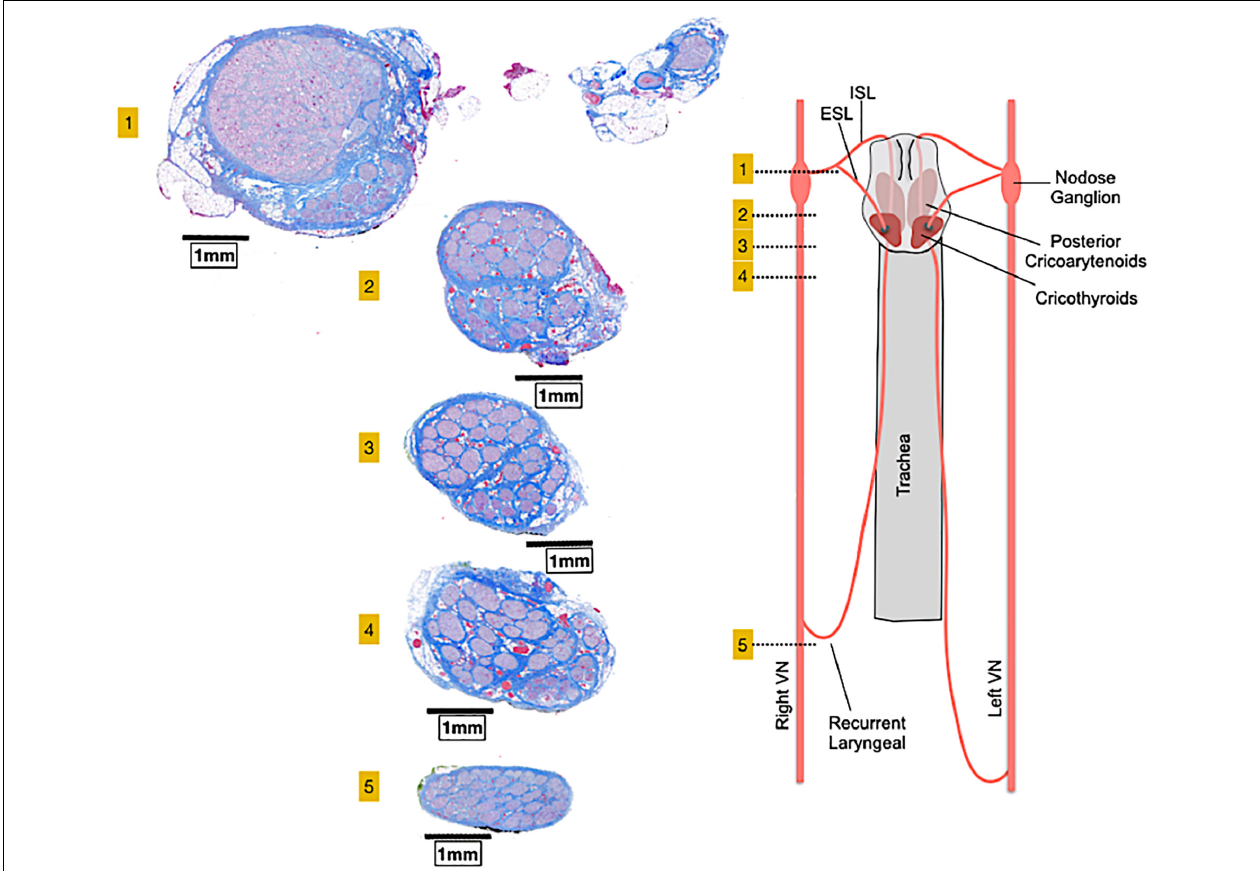
FIGURE 2 | A bimodal arrangement, or vagotopy, can be observed in histological sections collected at various levels along the pig vagus nerve. Section 1 comprises the nodose ganglion and the superior laryngeal branch and show pseudo-unipolar cells grouped in a huge “fascicle” from which arises a smaller group of fascicles in sections 2, 3, and 4. Caudally to the recurrent laryngeal nerve (section 5), the bimodal architecture is no longer visible. ESL, external superior laryngeal nerve; ISL, internal superior laryngeal nerve, VN, vagus nerve. Adapted from Settell et al. (44).